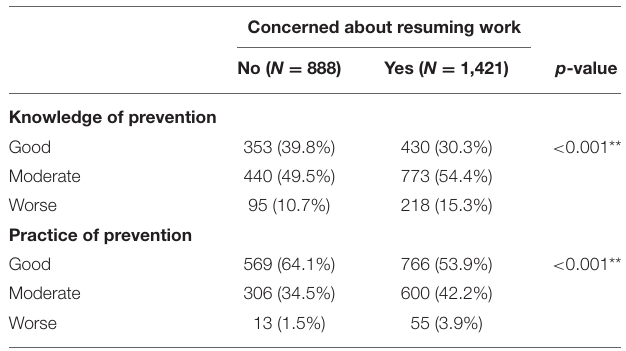
TABLE 5 | Association between concerns about resuming work and knowledge and practice of COVID-19 prevention measures.